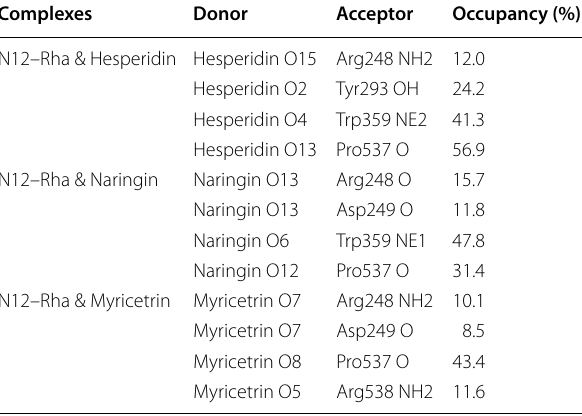
Table 2 Hydrogen bond occupancy during 15–20 ns MD simulation